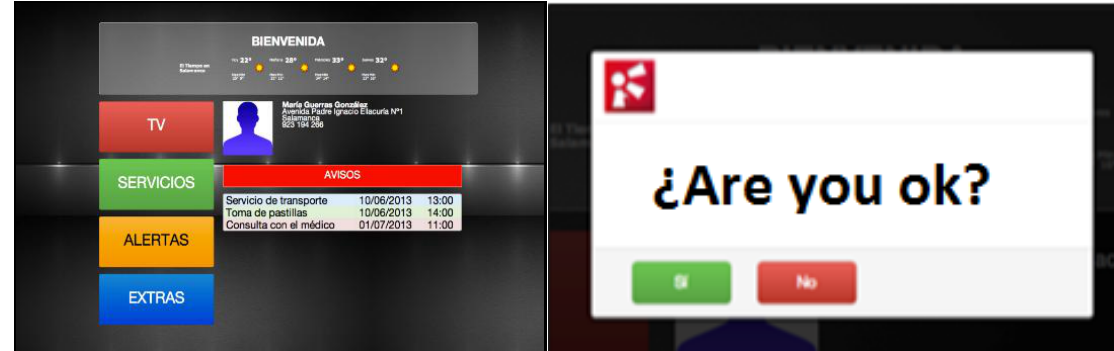
Figure 9. Interaction with the user through